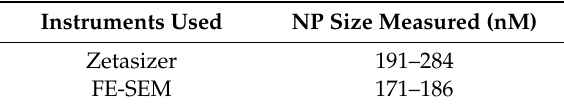
Figure 4. The size and morphology of various nanocrystal samples visualized through FE-SEM (field emission scanning electron microscope; HitachiS-4700 FE-SEM, Japan). Particle aggregations ( a ) and individual particles size ( b ) were observed. Table 3. Particle size measurement of the CA NPs prepared in 200 µ L Dulbecco’s modified Eagle microscopy (FE-SEM).